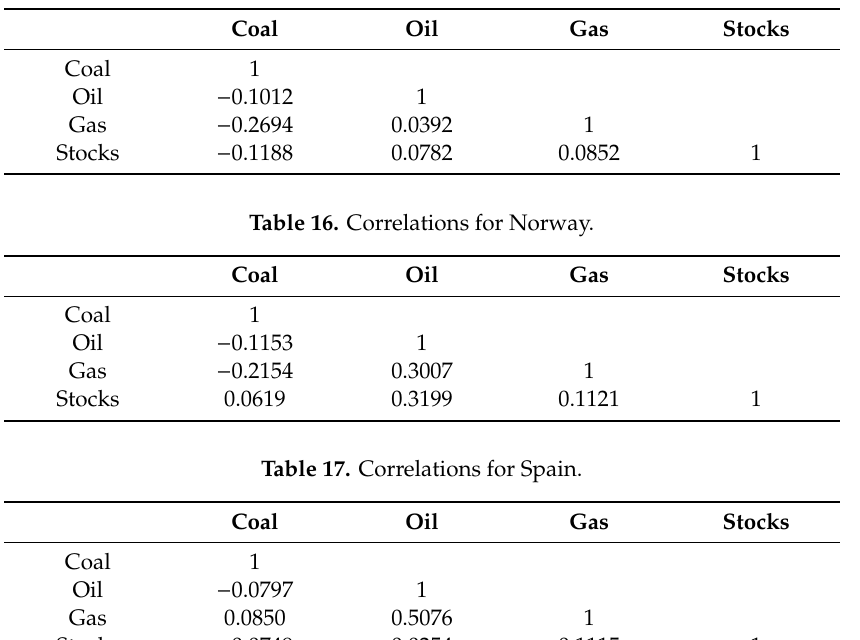
Table 15. Correlations for The Netherlands.